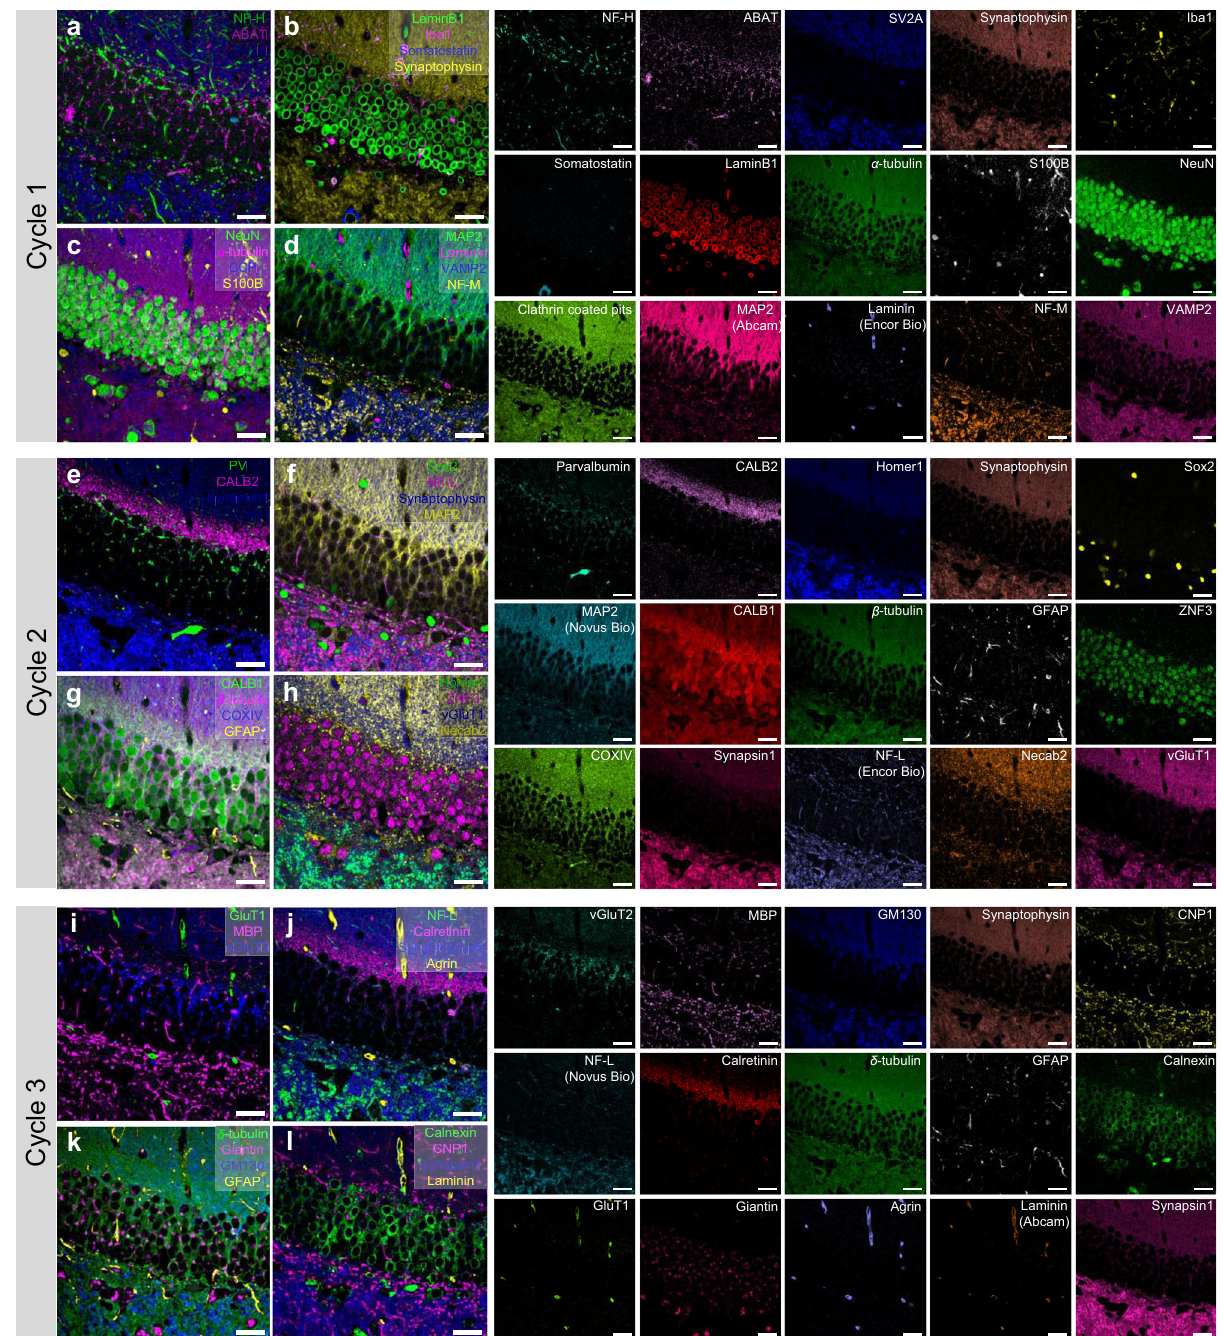
Fig. 7 Forty- fi ve-color multiplexed imaging via Cyclic-PICASSO. a – d Overlay of three or four channels chosen from 15-color images of cycle 1 imaging to visualize different sets of biologically relevant channels together. Individual images were presented on the right side of a – d . e – h Overlay of the three or four channels chosen from the 15-color images of cycle 2 imaging. The individual images were presented on the right side of e – h . i – l Overlay of the three or four channels chosen from 15-color images of cycle 3 imaging. The individual images were presented on the right side of i – l . Synaptophysin in each cycle was used as a fi ducial marker. All scale bars; 30 μ